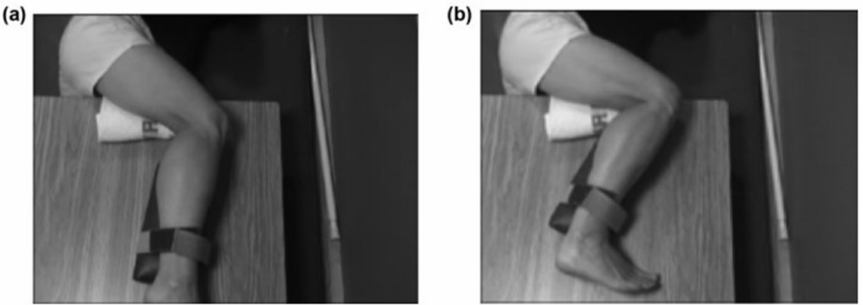
Figure 2. In-Synergy Position for Knee Flexion Practice. Panel ( a ) is the start position of the exercise. The position is shown from a semi-aerial view, looking down on the exercise board (powder board with short wooden legs to hold the board off the mat and off the uninvolved leg, which is resting on the mat). The position of training is side-lying with the uninvolved leg resting on the mat. The involved leg is resting on the top of the exercise board. The in-synergy start position for knee flexion practice is with the joint(s) contiguous to the knee (hip and ankle) in a flexed position. Panel ( b ) shows the end position of the knee flexion exercise, with the knee as fully flexed as can be performed. The hip is in a flexed position throughout (with permission, JRRD, 2012, Daly et al. [31]).